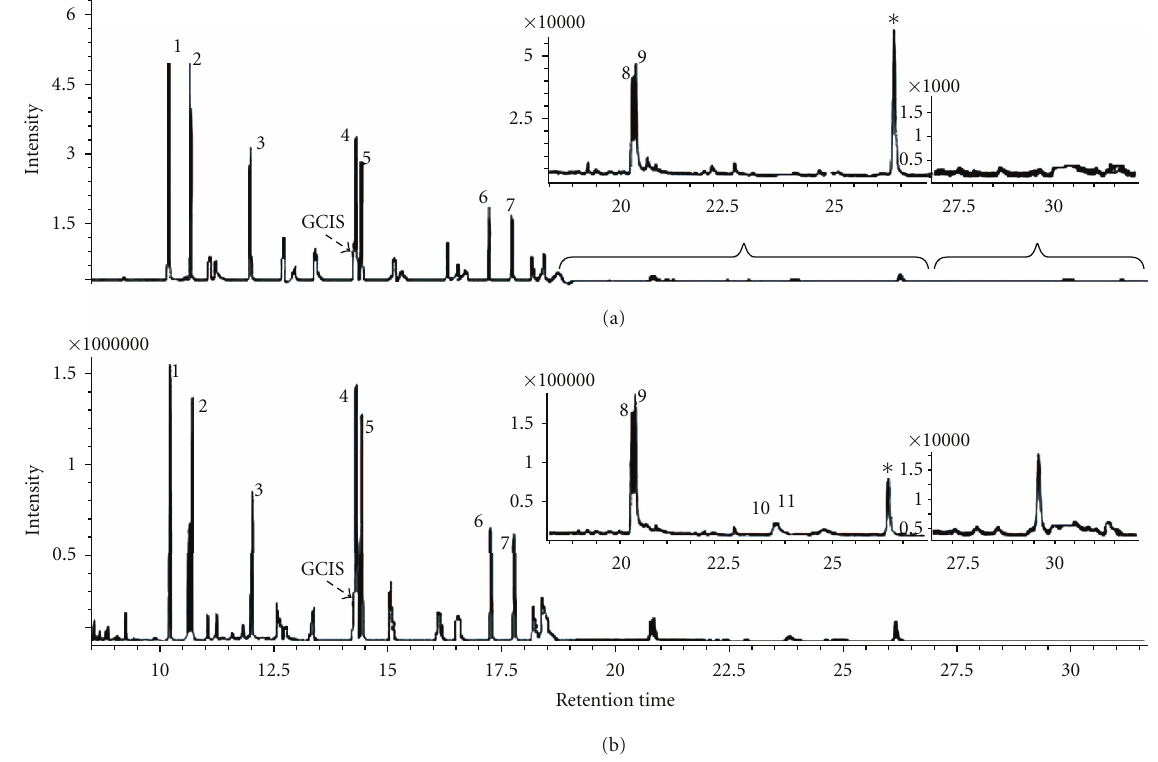
Figure 4: Chromatograms of target compounds enriched by HS-LPME (a) and GP-HS-LPME (b) 1: Acenaphthylene; 2: Acenaphthene; 3: Fluorene; 4: Phenanthrene; 5: Anthracene; 6: Fluoranthene; 7: Pyrene; 8: Benzo[a]fluoranthene; 9: Chrysene; 10: Benzo[b]fluoranthene; 11: Benzo[k]fluoranthene. Table 1: Comparison of the GP-HS-LPME and